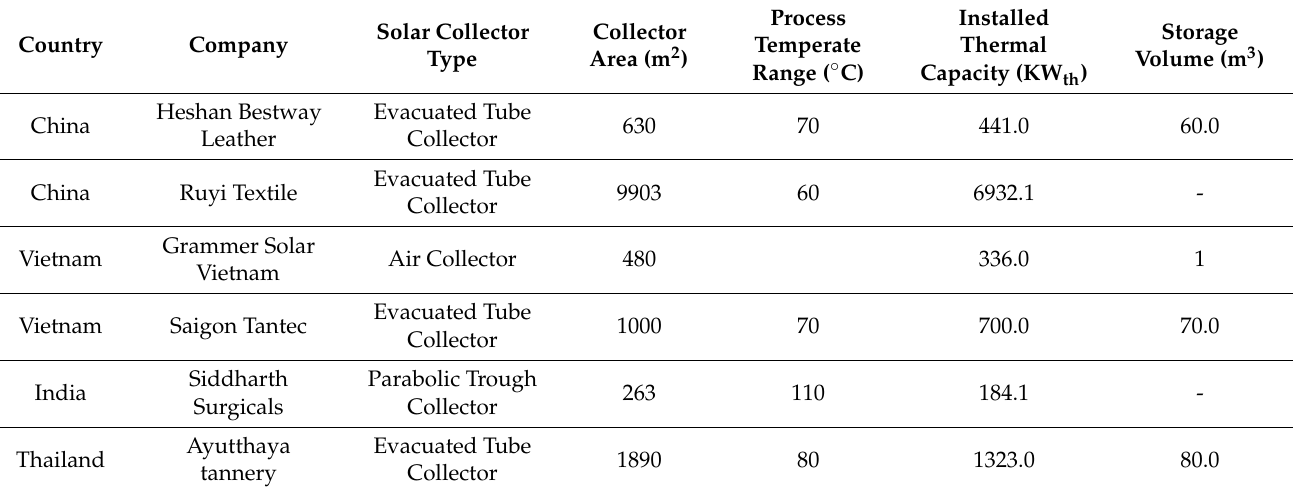
Table 5. Process-level integration for make-up water heating in existing Textile & Leather indus- tries